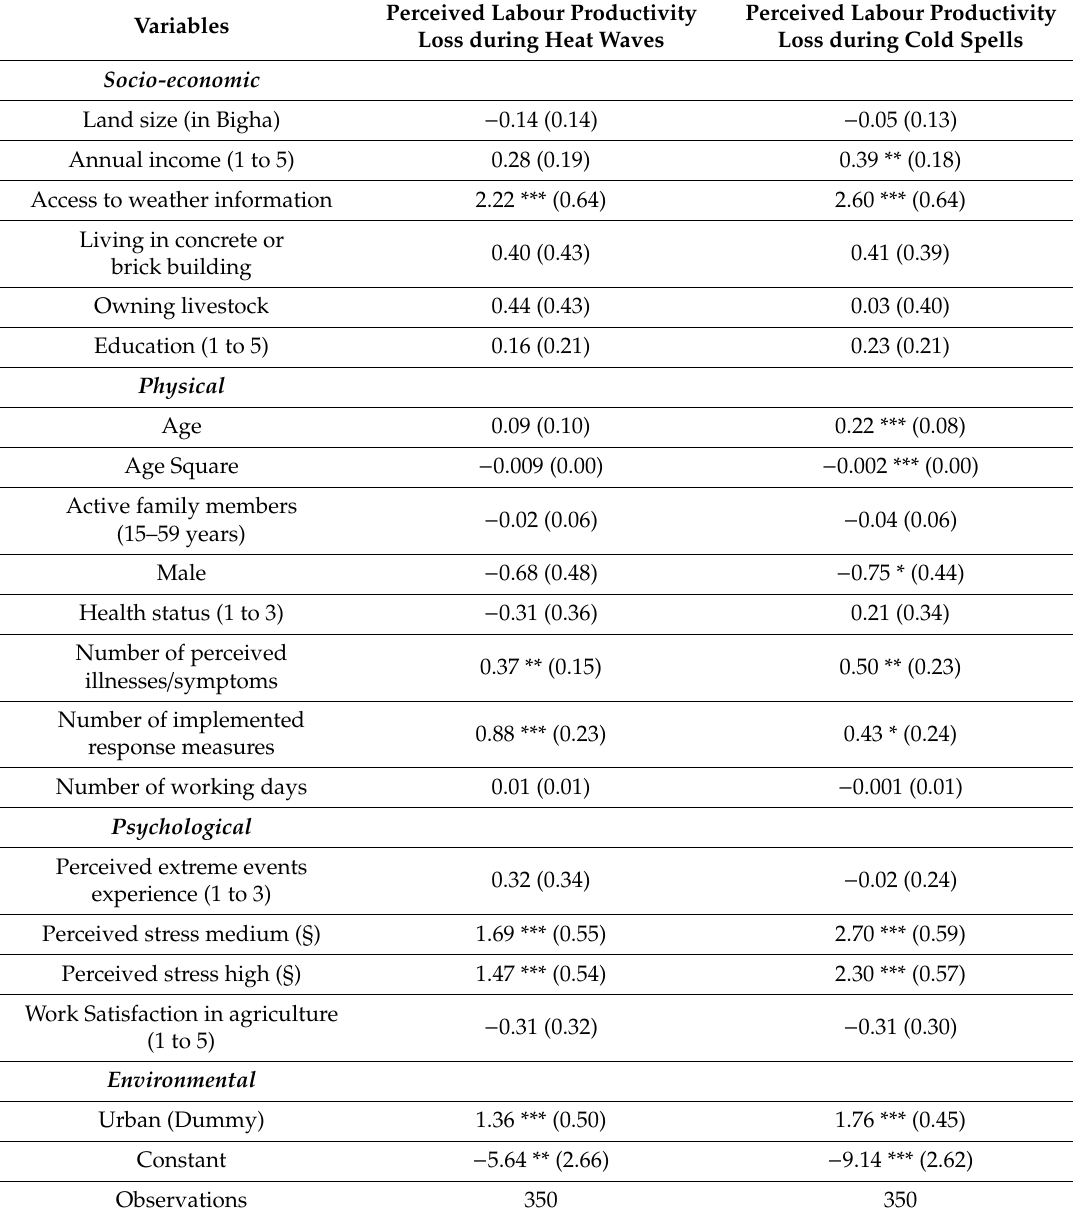
Table 4. Determinants of self-reported labour productivity